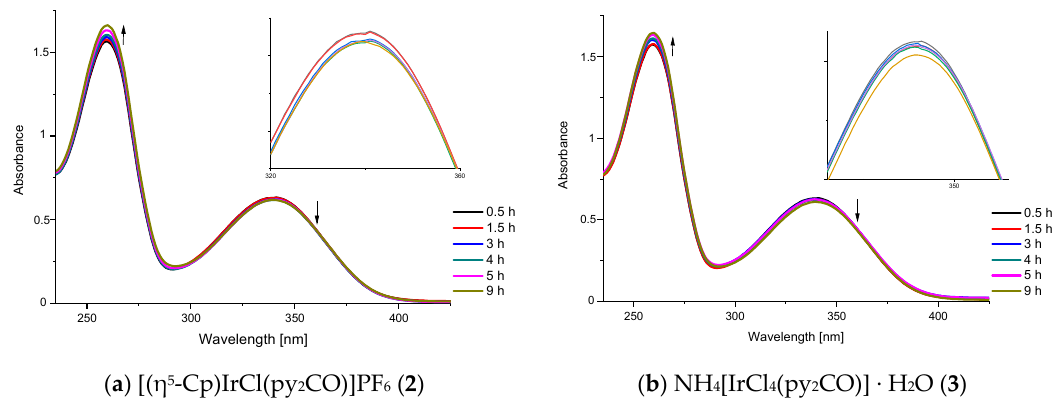
Figure 12. UV-Vis spectra for the catalytic oxidation of NADH (100 µM) to NAD + in the presence of complexes (1 µM) over a 9 h period in 50% MeOH/50% H 2 O (V:V) (inset: wavelength absorbance changes from 315-360 nm).